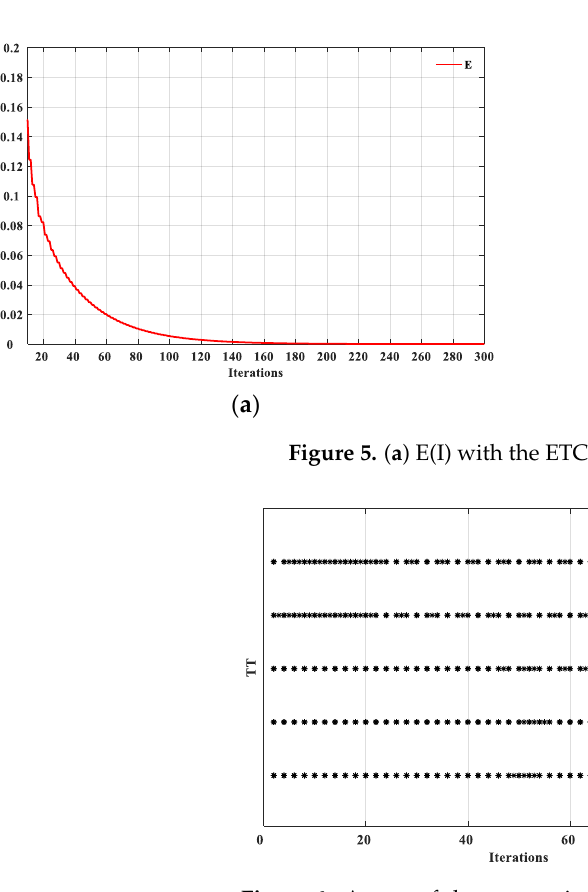
Figure 6. A part of the event-triggered timing (TT) of agent 1–agent 5. From top to bottom are agents 1, 2, 3, 4, 5.